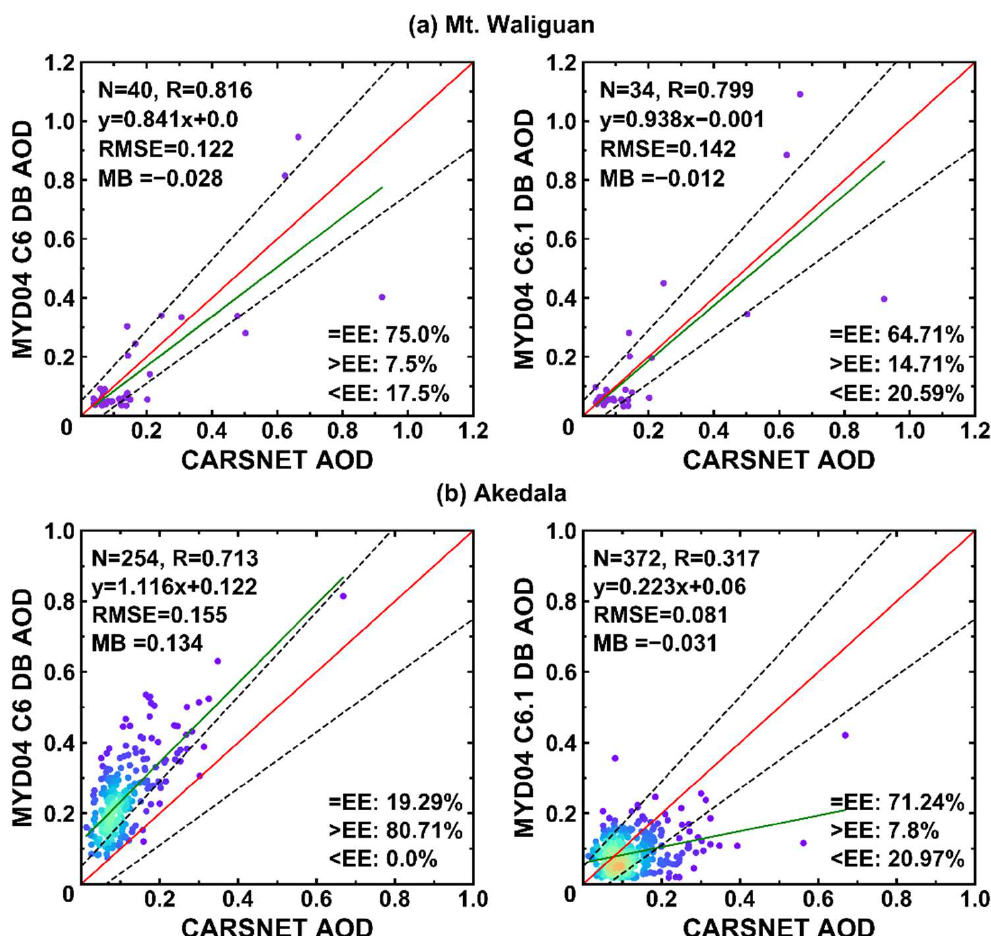
Figure 8. Validation of MODIS C6 ( left ) and C6.1 ( right ) DB AOD against ground-based AOD at 2 remote sites. One-one line, linear regression line, and the EE envelopes are plotted as red solid, green solid, and black dashed lines. ( a ) Mt. Waliguan; ( b ) Akedala.